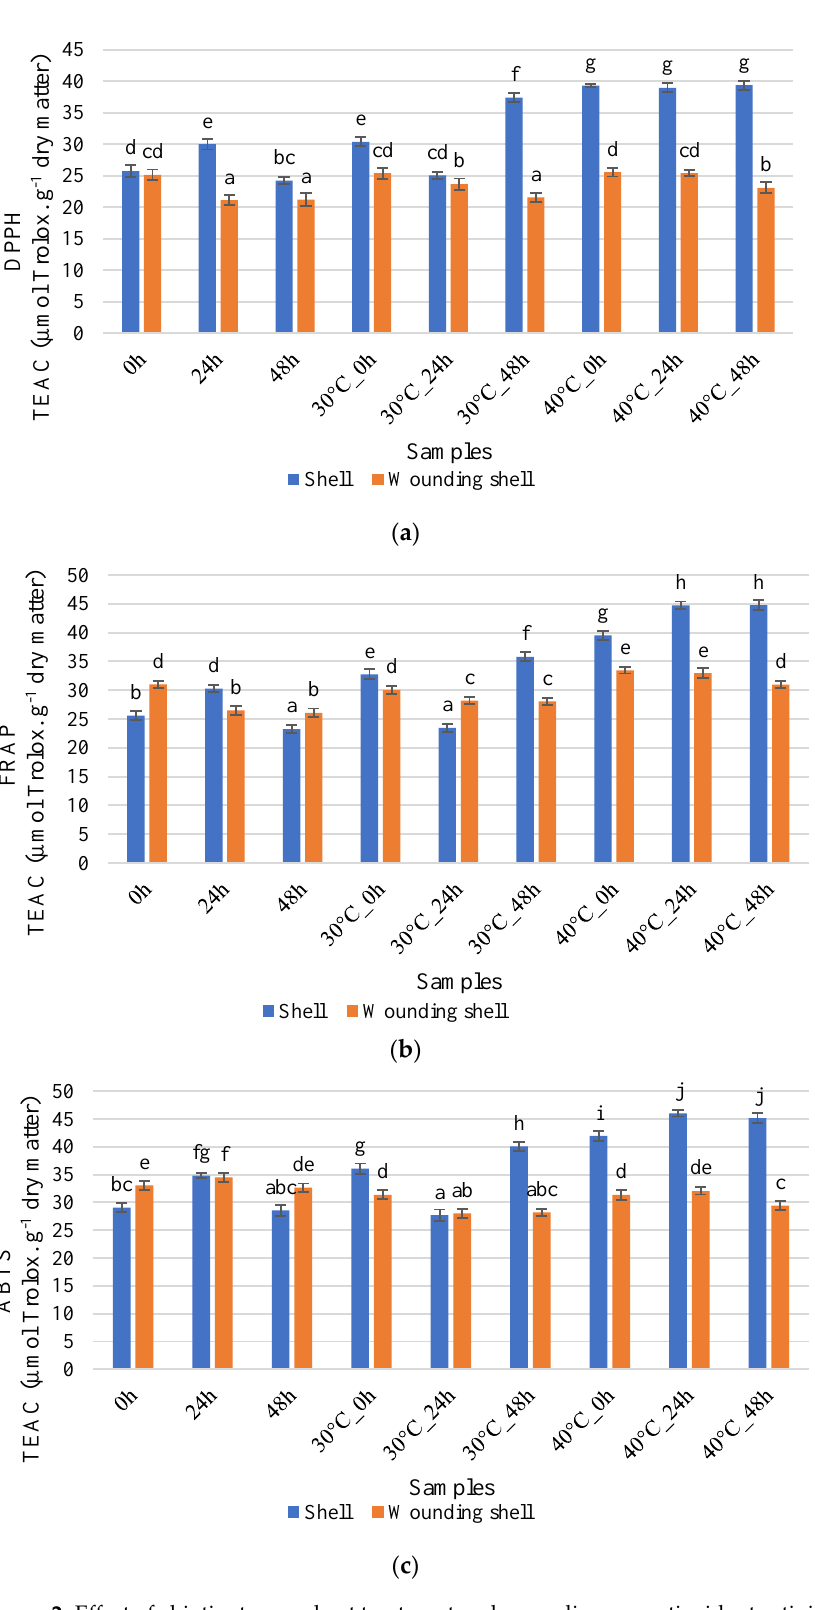
Figure 2. Effect of abiotic stresses, heat treatment and wounding, on antioxidant activity of pineapple shell: ( a ) DPPH (2,2-diphenyl-1-picrylhydrazyl); ( b ) FRAP (Ferric Reducing Antioxidant Power); and ( c ) ABTS (2,2’ -azino-bis (3-ethylbenzothiazoline-6-sulphonic acid)). Error bars stand for ± standard deviation ( n = 9). Different letters express significant differences between samples.